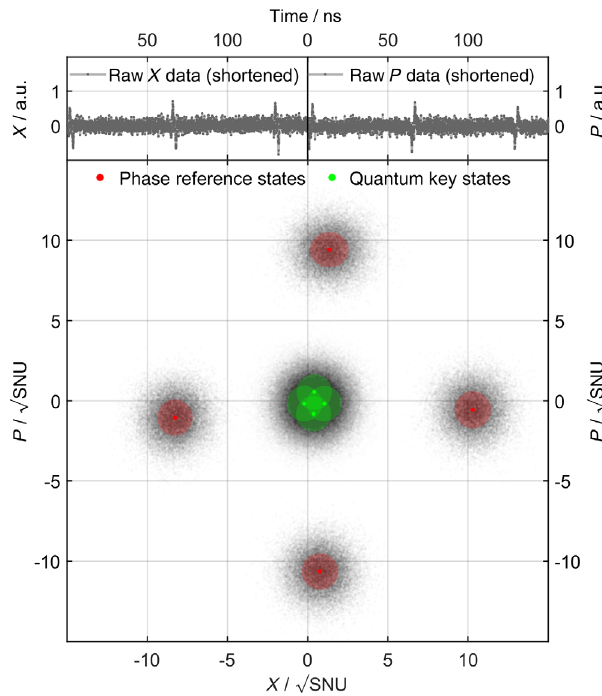
FIG. 5. Top: raw quadrature data traces produced by our quantum communication system running QPSK modulation [35]. Bottom: a resulting phase-space constellation diagram after digital signal processing is applied to the raw data. Shaded circles indicate the means and variances of the coherent states sent and received, including quantum key states (green) and auxiliary phase reference states (red). SNU: shot noise unit, defined as the quadrature variance which is measured when no signal input